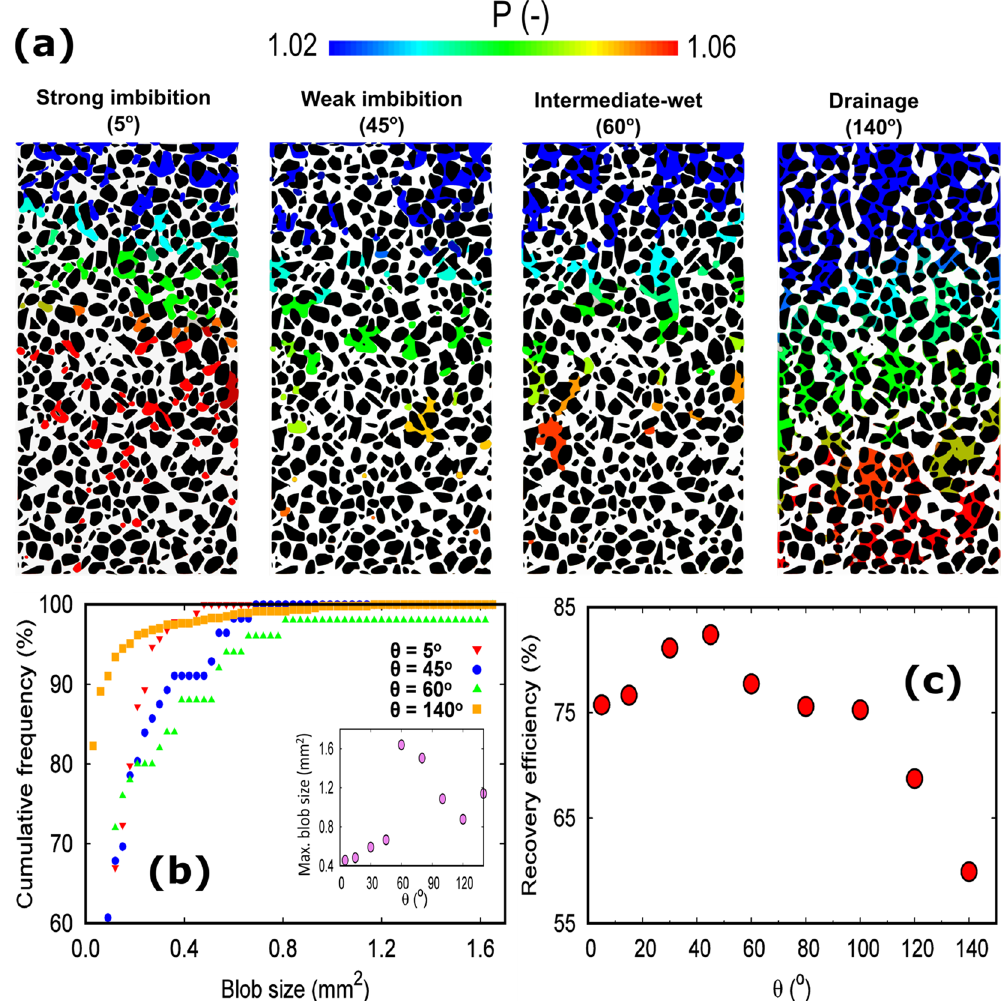
Figure 2. ( a ) Fluid phase and pressure distribution under different wetting conditions at the end of simulation. White colour represents pathway of invading phase. Pressure is normalized with respect to the outlet pressure and it indicates the pressure in the defending phase. ( b ) Distribution of blobs size of defending fluid under different wettability scenarios. The inset illustrates the maximum blob size as a function of the contact angle. ( c ) The non-monotonic dependency of the defending phase recovery on the wettability of porous